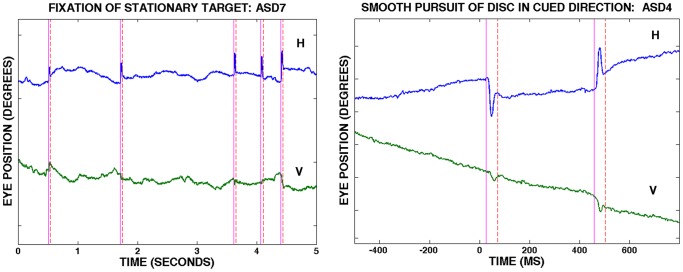
Representative Eye Traces During Fixation and During Smooth Pursuit.(Left) Representative record showing horizontal (H) and vertical (V) eye movements over time during 5 seconds of fixation of the stationary target. Participant ASD7. (Right) Representative record showing horizontal (H) and vertical (V) eye movements during 1.3 seconds of smooth pursuit of the disc moving down the tube; cued condition. The disc entered the right oblique branch at time  =  0. Participant ASD4. The vertical lines represent computer-generated markers showing beginning and end of saccades. Upward deflections indicate movements to the right or up. The separation between tic marks on the ordinate are 1 degree (60 min arc). Horizontal anticipatory smooth eye movements to the right, in the direction of cued motion, can be seen prior to time = 0 in the graph on the right.